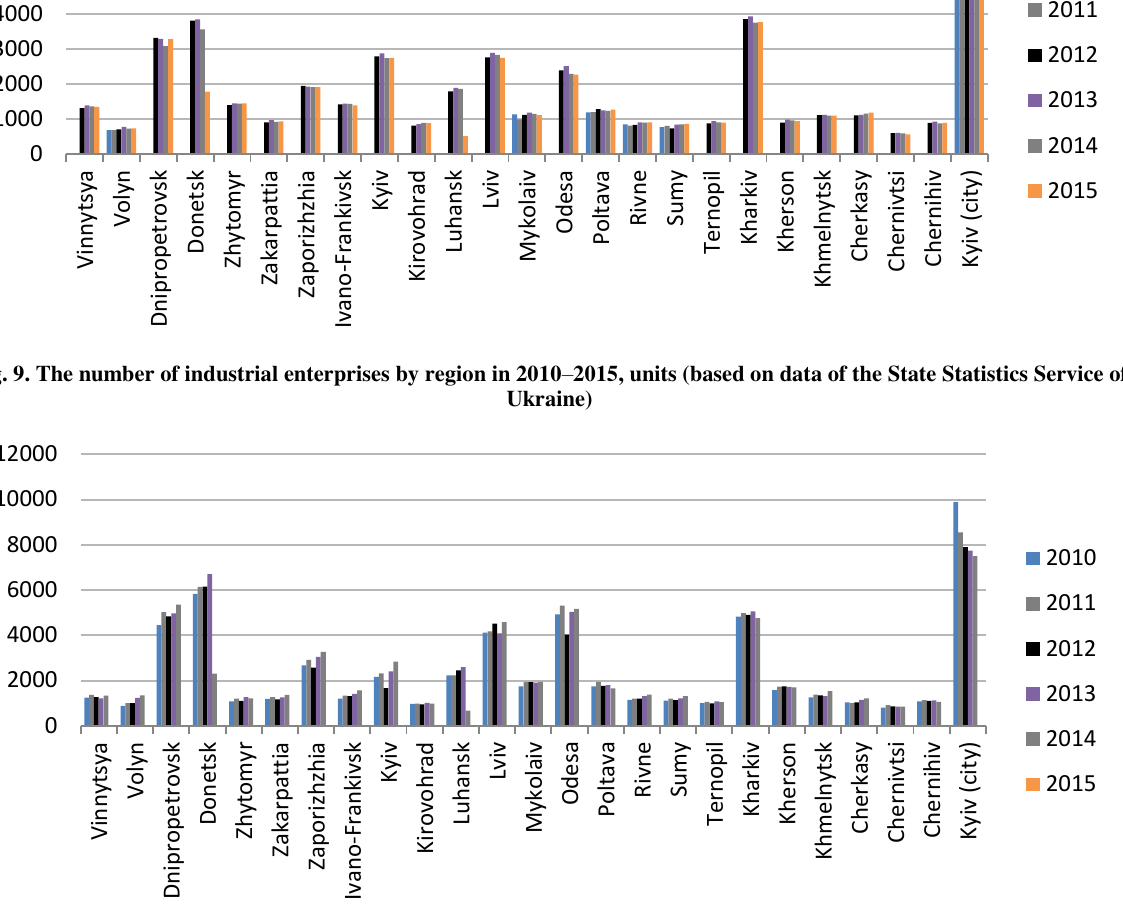
Fig. 10. The number of services sector enterprises by region in 2010 – 2015, units (based on data of the State Statistics Service of Ukraine